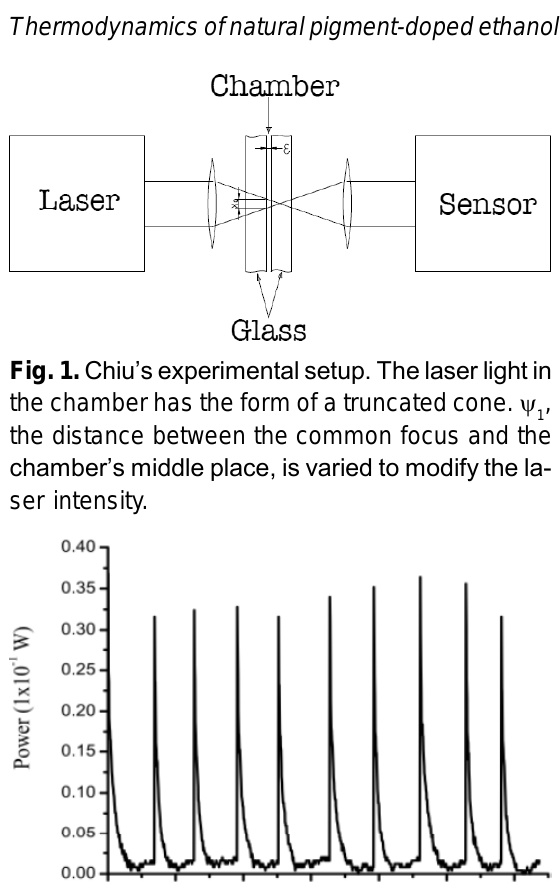
Fig. 2. Laser power recorded by sensor.